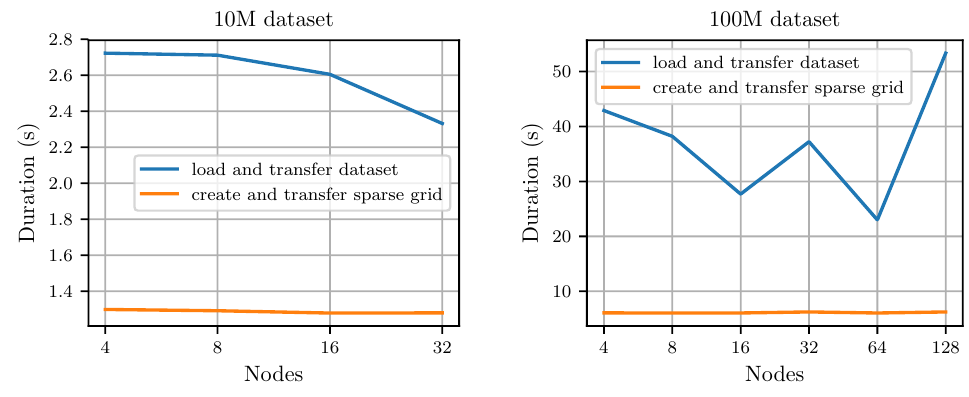
Figure 9. Strong scaling results for both the 10M (left graphs) and 100M (right graphs) Gaussian dataset on Piz Daint. Figure 9a,b show duration and performance of the major computed kernels and the application as a whole. The duration of other (minor) tasks is shown in Figure